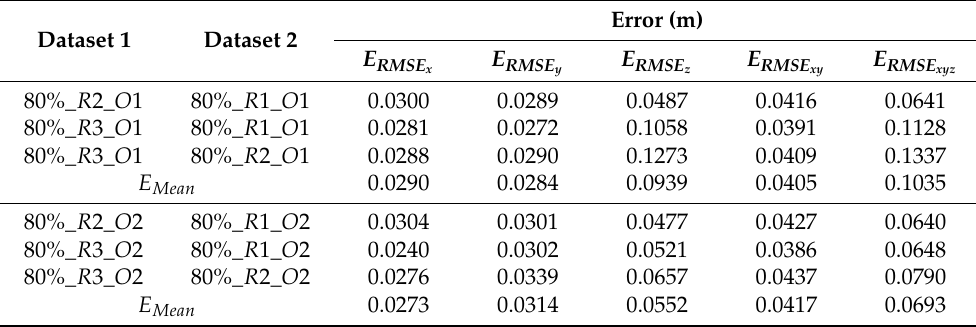
Table 5. The difference results of 3D scene checkpoint model values of different datasets under the identical data